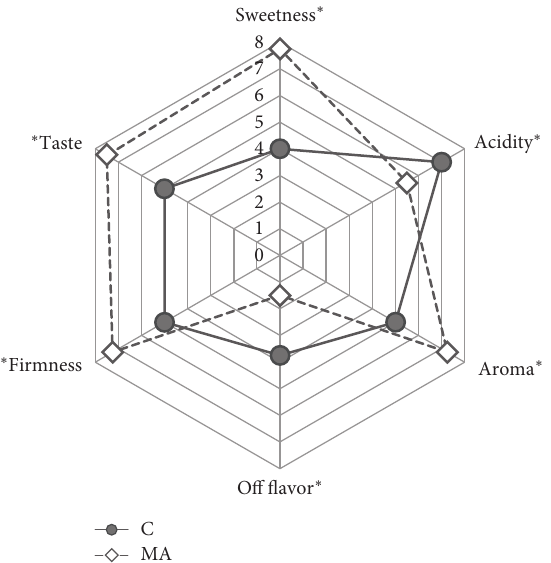
Figure 3: Sensory analysis of untreated (C) and treated ( O. ficus- indica mucilage in combination with ascorbic acid-MA) strawberry “Fortuna” fruit, after 12 days of storage at 4 ° C. Data are Mean of 15 fruit for each treatment. ∗ Significant differences for values (Tukey’s test at p ≤ 0 . 05).